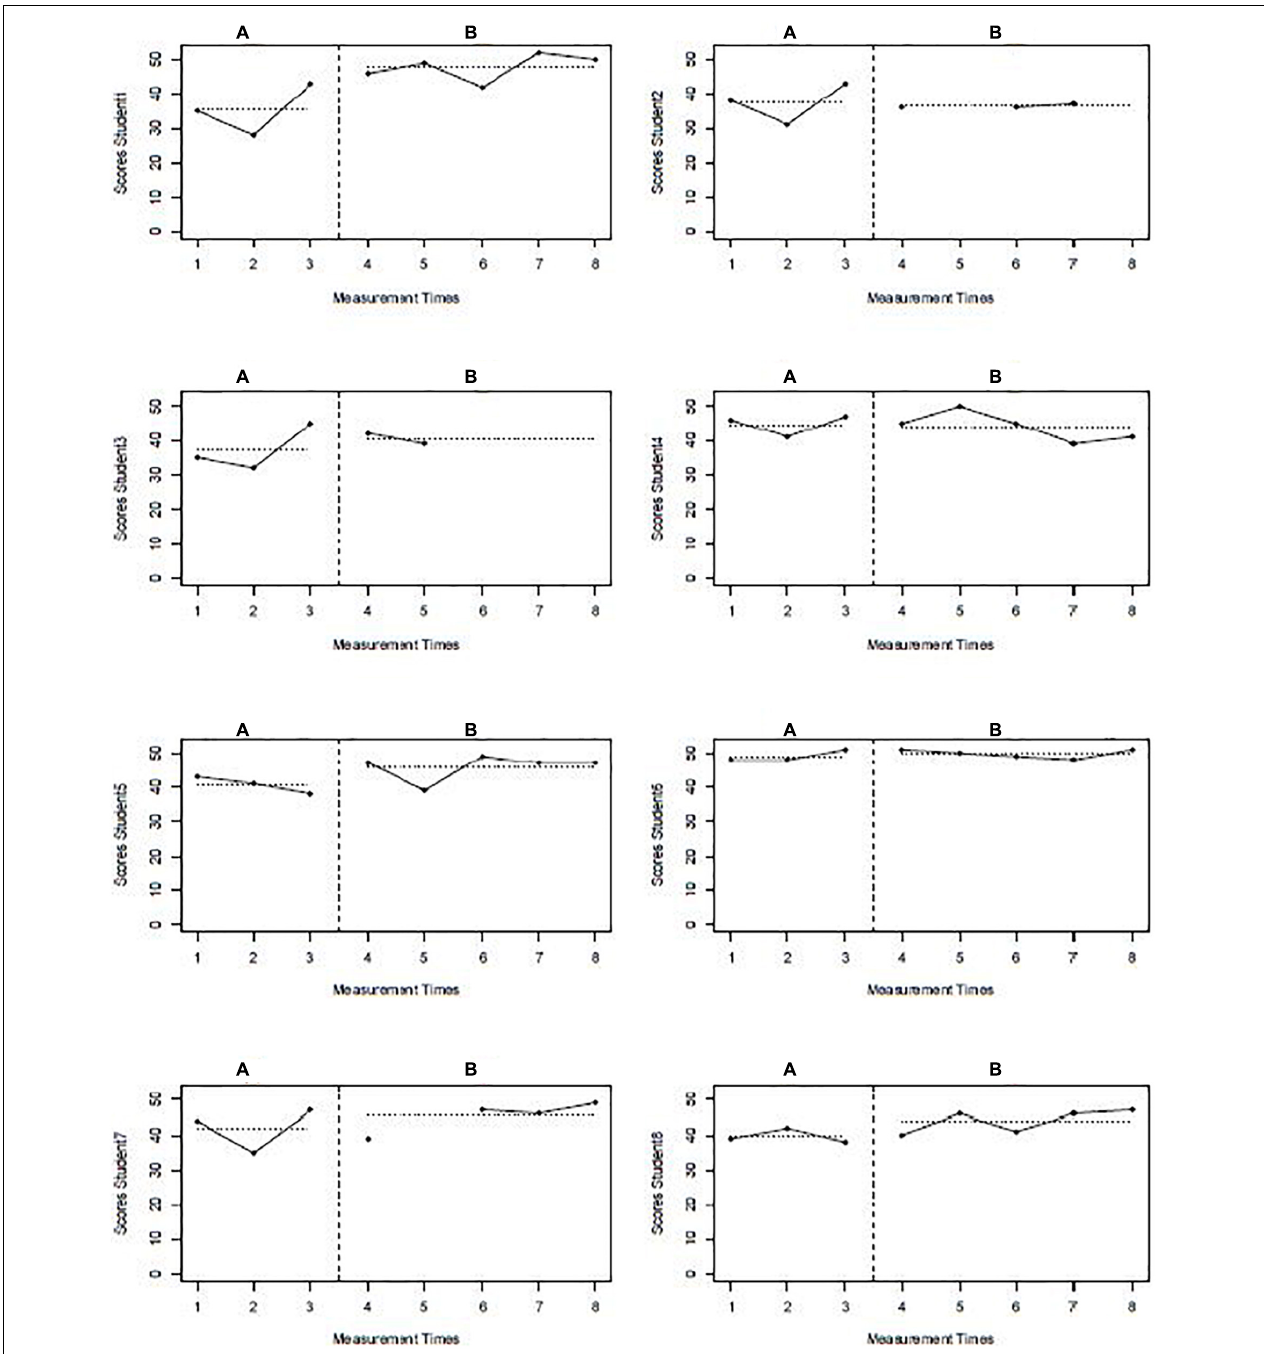
FIGURE 2 | Baseline (A) and intervention (B) phases for essay total score for each participant ( n = 8).